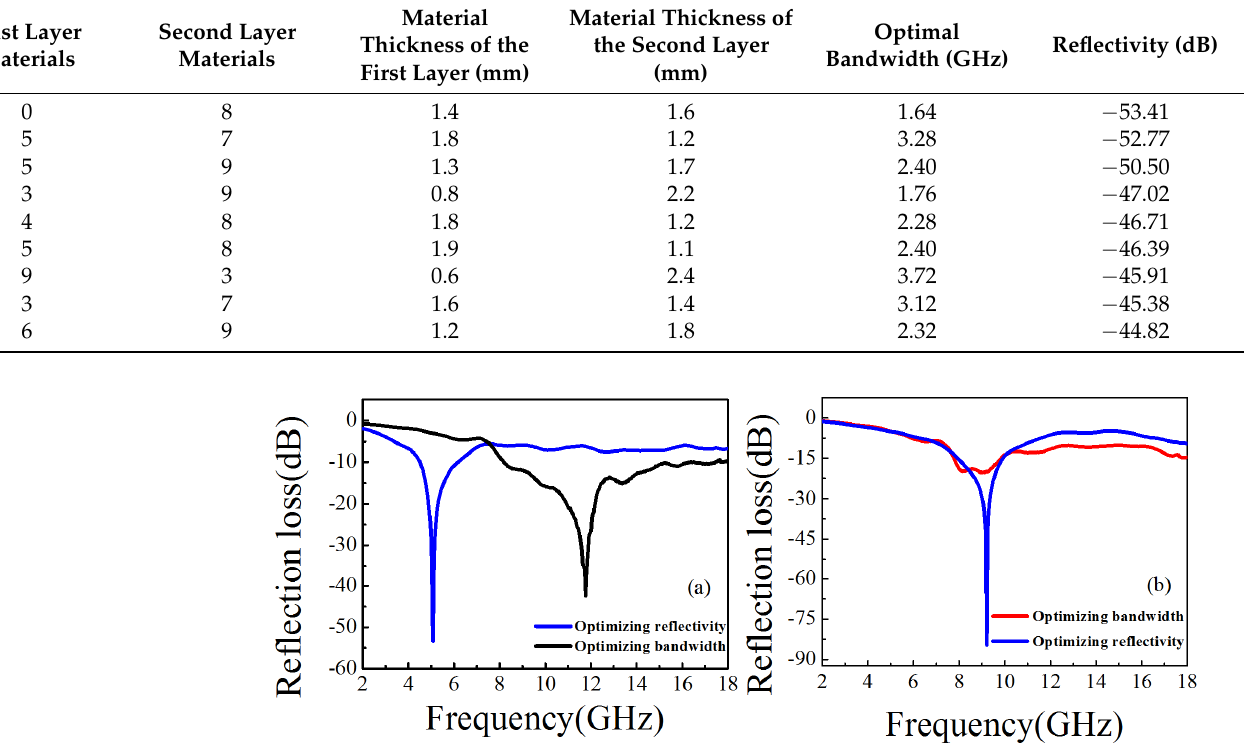
Figure 7. The optimized curves for the two-layer materials ( a ); the optimized curves for the three- layer materials ( b ). Table 5. The optimization results using objective function F2 (three-layers) of GA algorithm.